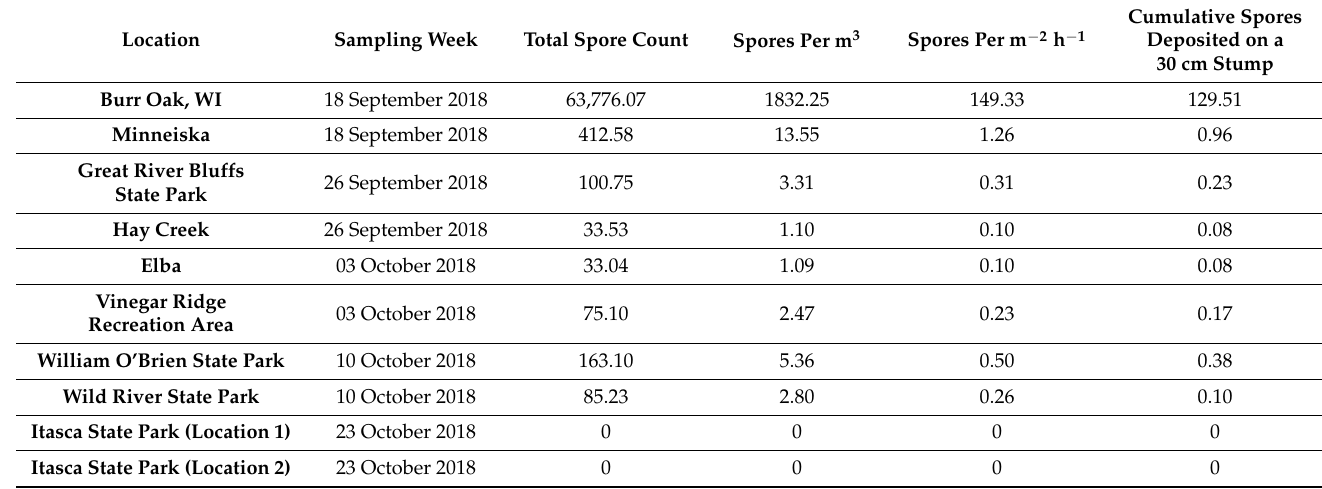
Table 1. Number of H. irregulare mononuclear spores collected at different locations in Minnesota and Wisconsin. The total spore count and other calculations were an average of both rods from each